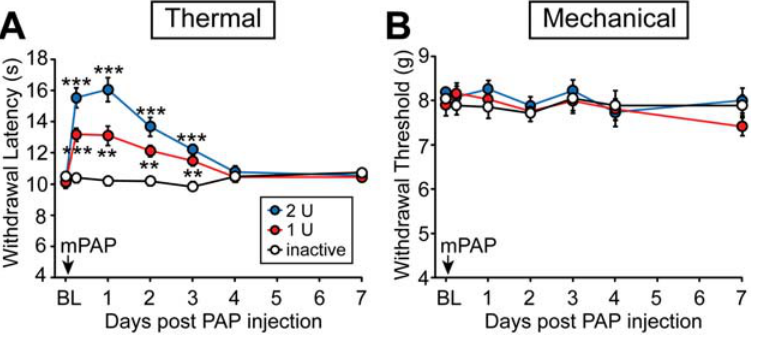
Figure 5. Dose-dependent antinociceptive effects of intrathecal mPAP. (A) Effects of increasing amounts of mPAP on paw withdrawal latency to a radiant heat source. (B) Paw withdrawal threshold to a semi-flexible tip mounted on an electronic von Frey apparatus. (A, B) BL=Baseline. Injection (i.t.) volume was 5 m L. n=8 wild-type mice were used per dose. There were significant differences over time between mice injected with heat-inactivated (0 U) mPAP and mice injected with active (1 U or 2 U) mPAP (Repeated measure two-way ANOVA; P , 0.0001 for each dose). Post- hoc paired t-tests were used to compare responses at each time point between mice injected with active mPAP to mice injected with heat- inactivated mPAP (** P , 0.005; *** P , 0.0005). For the heat-inactivated mPAP control, the protein concentration was equivalent to the maximum 2 U dose of mPAP (1.1 mg/mL). All data are presented as means 6 s.e.m.